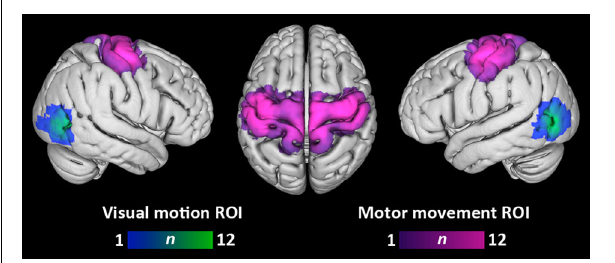
FIGURE 2 | Overlap of visual motion and motor movement regions-of-interest across participants. Each participant’s ROIs have been transformed into standard MNI space. Color bars denote the number of participants having a given ROI at each voxel. Overlap is displayed at a search depth of